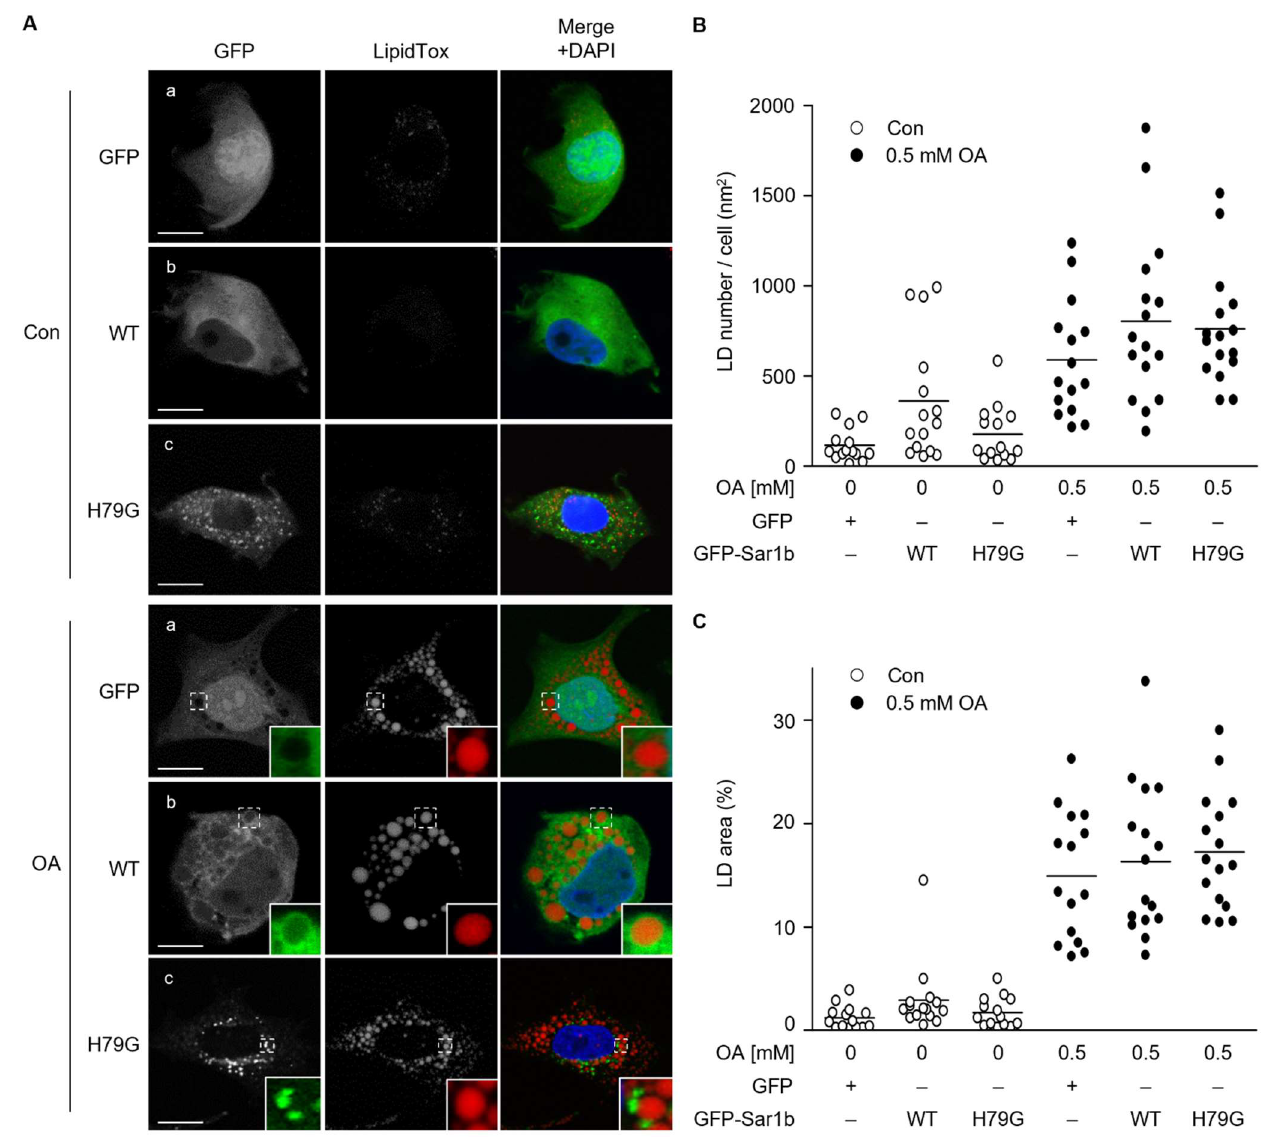
Figure 1. Peripheral localization of GFP-Sar1b WT on lipid droplet in oleic acid-treated cells. ( A ) HuH7 cells transiently expressing GFP ( a ) GFP-Sar1b WT ( b ) GFP-Sar1b H79G ( c ) were treated with (OA) or without (Con) 0.5 mM oleic acid for 24 h. The cells were stained with LipidTox and DAPI. Boxed areas are shown in higher magnification in the insets. Bar, 10 μm. Data are representative of experiments repeated at least three times. ( B ) The number of LDs per area in ( A ) are shown. Results are shown as a scattered dot plot. p- Values for GFP Con vs. GFP-Sar1b WT Con; and GFP OA vs. GFP-Sar1b WT OA were 0.350 and 0.417, respectively. ( C ) The ratio of LD area to total cell area in ( A ) are shown.